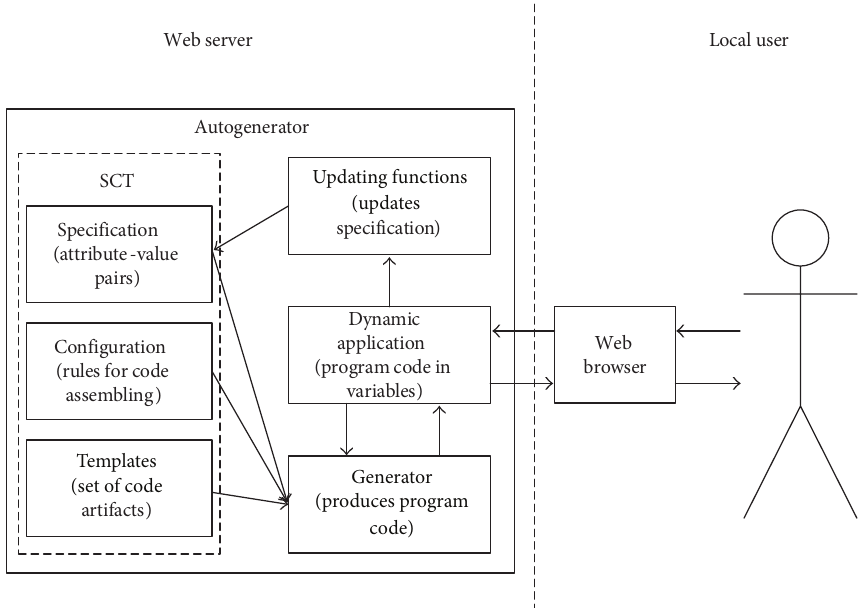
Figure 3: Updating attributes and their